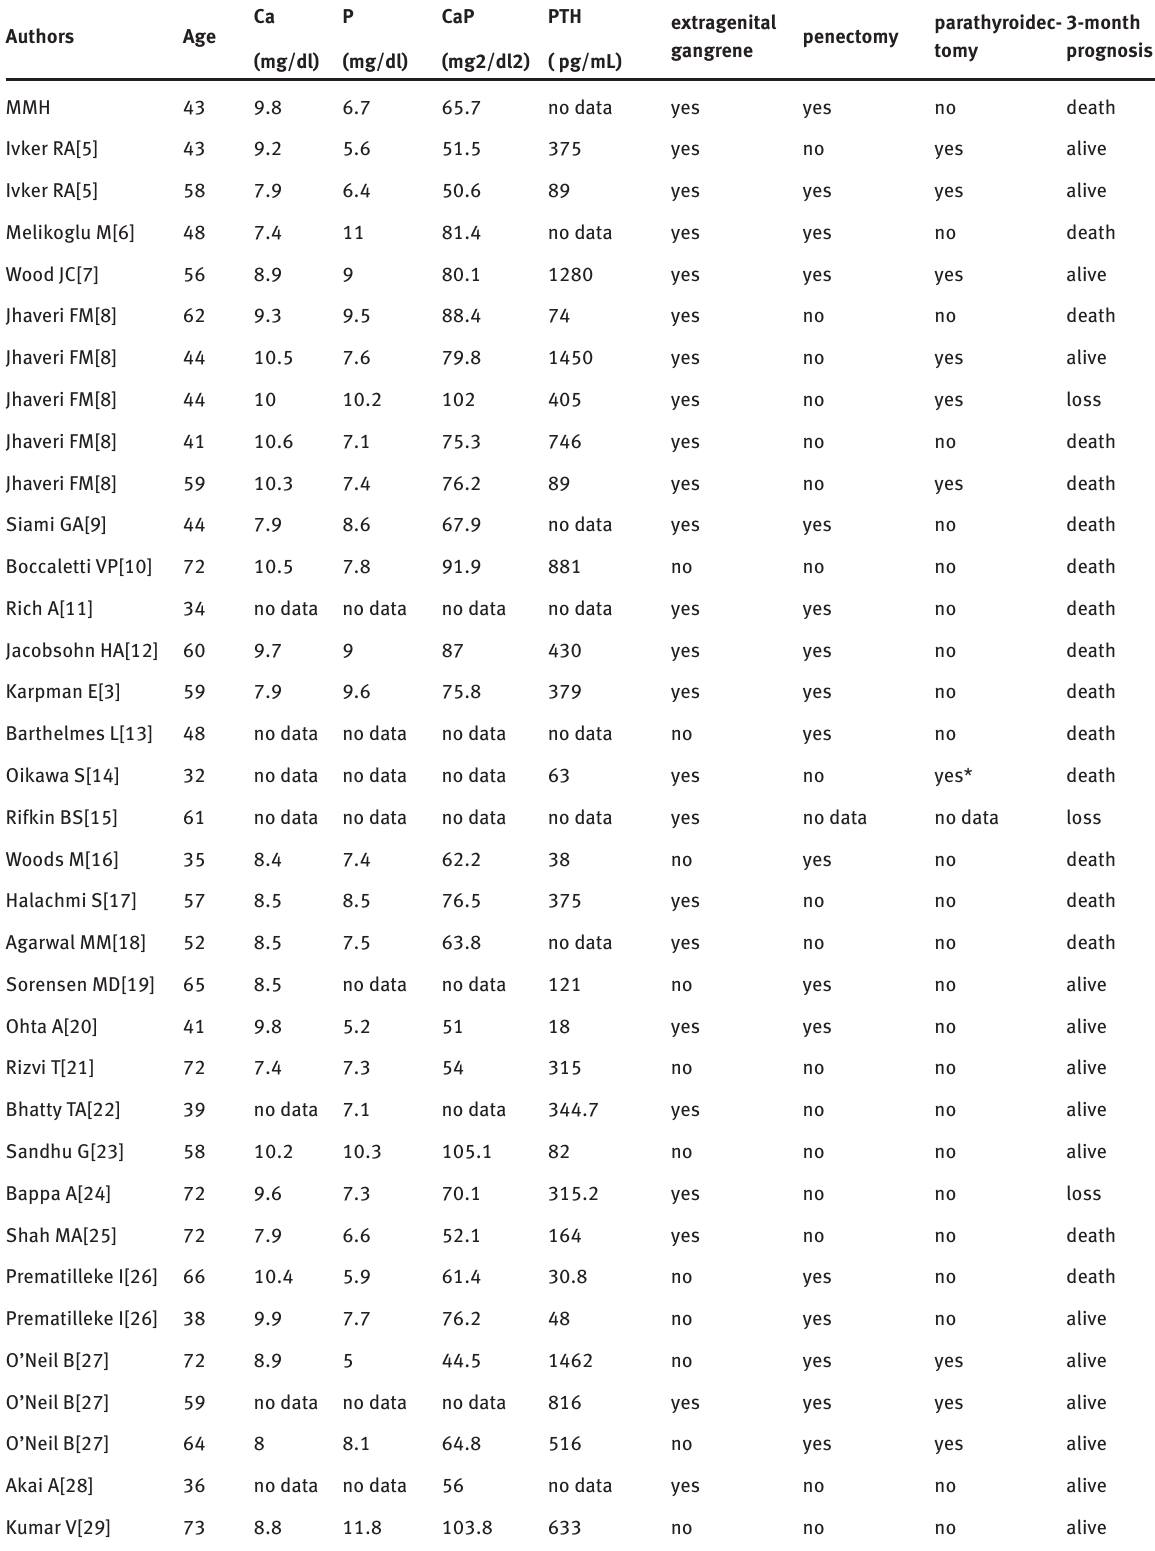
Table 1: Review of reported cases of penile calciphylaxis with end-stage renal disease.